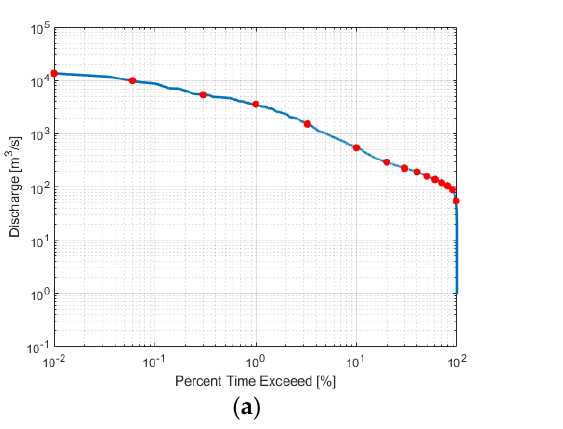
Figure 11. ( a ) Flow duration and ( b ) sediment rating curves from the predicted total sediment load from models M3, M6, M7, and M8 at Jindong.